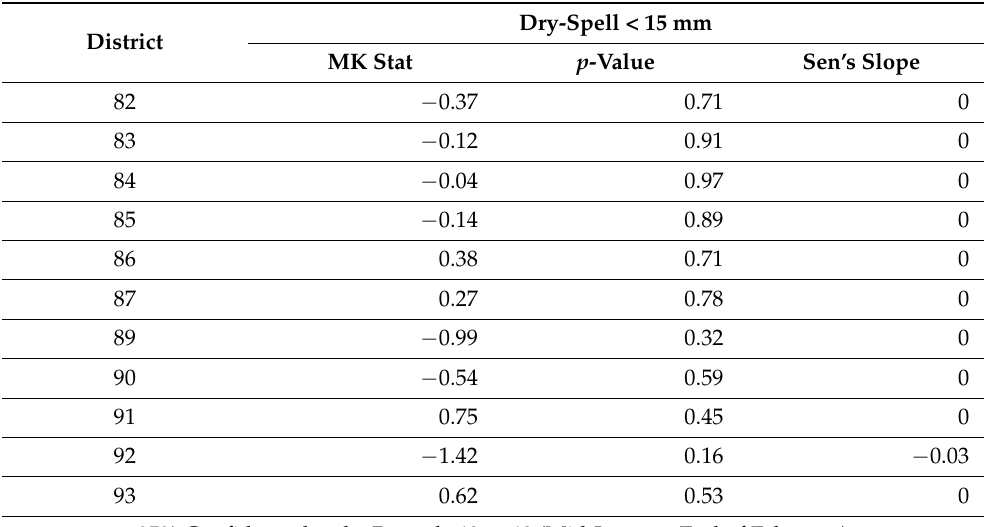
Table 4. Mann–Kendal and Sen’s slope analysis at 95% confidence interval for SAWS rainfall districts during pentads 40 to 48 (1985 to 2015).